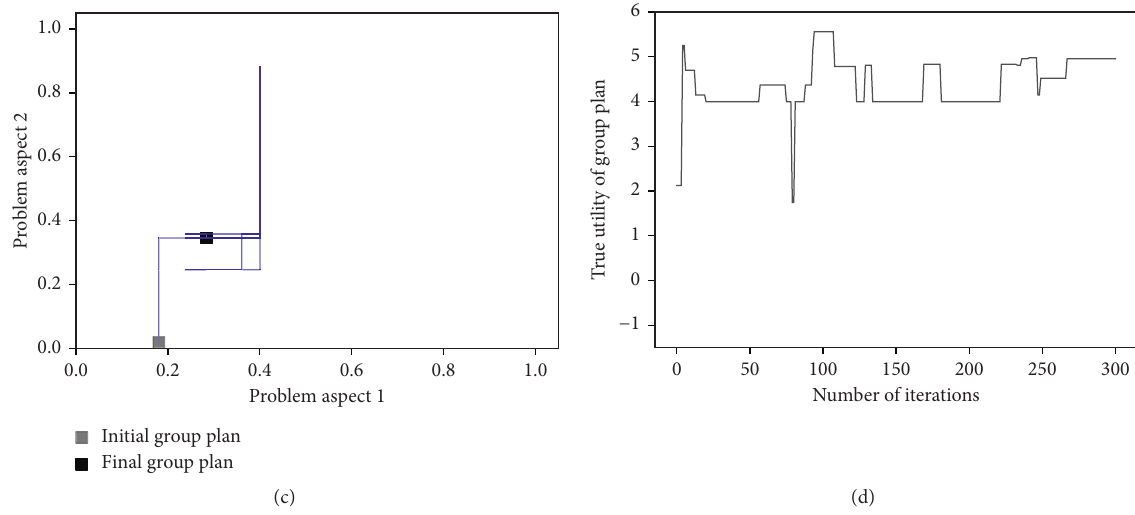
Figure 4: Simulation results of the representative 8-agent group. (a) Dynamical change of the agents’ perceived leaderships. The average of each agent’s perceived leadership is shown in this plot. (b) Quantities of adopted and rejected plans proposed by each agent. (c) The trajectory of the group plan. (d) The change of the group plan’s true utility. Note that agents’ attributes are defined in Table 2.